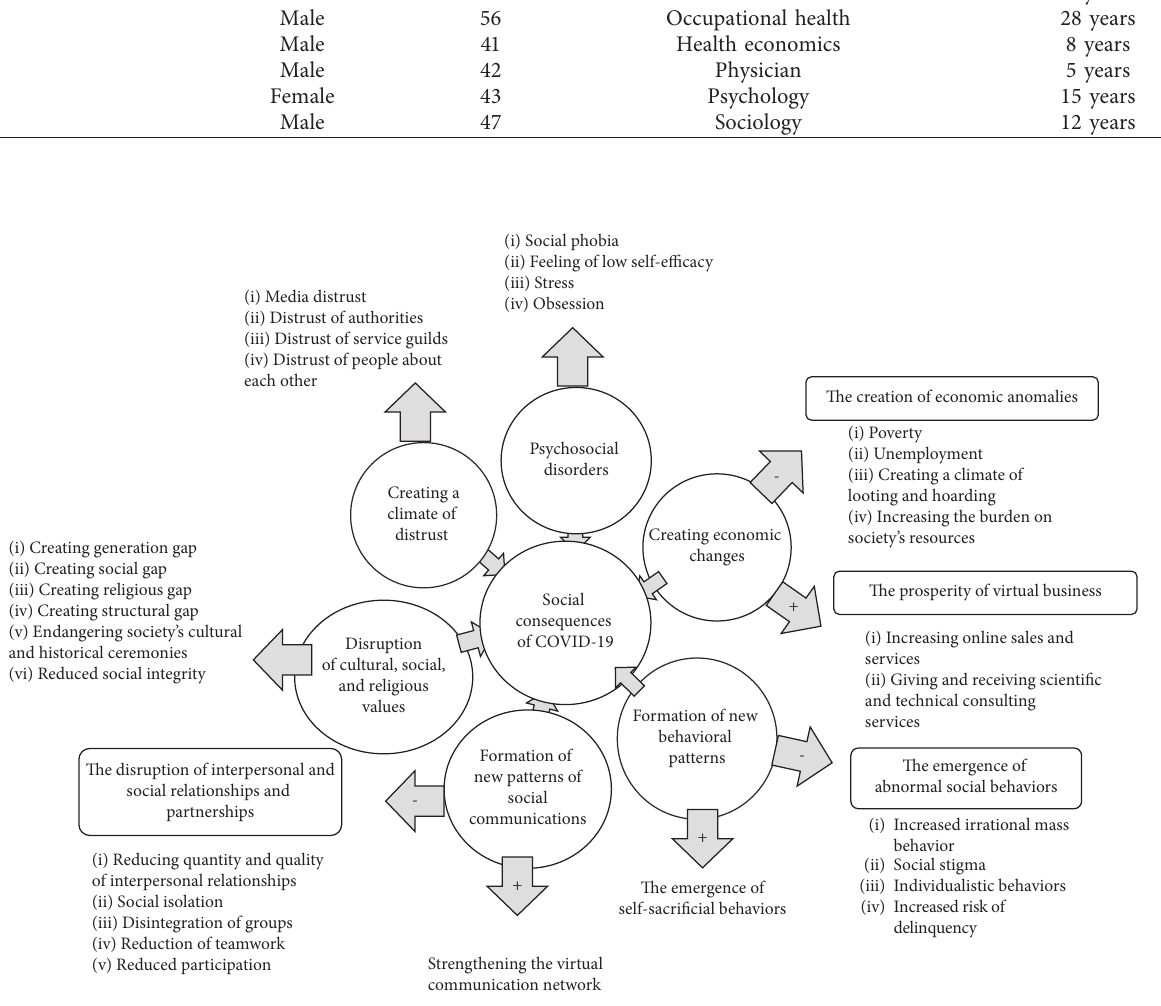
Figure 1: Categories and subcategories that highlight the social consequences of the COVID-19